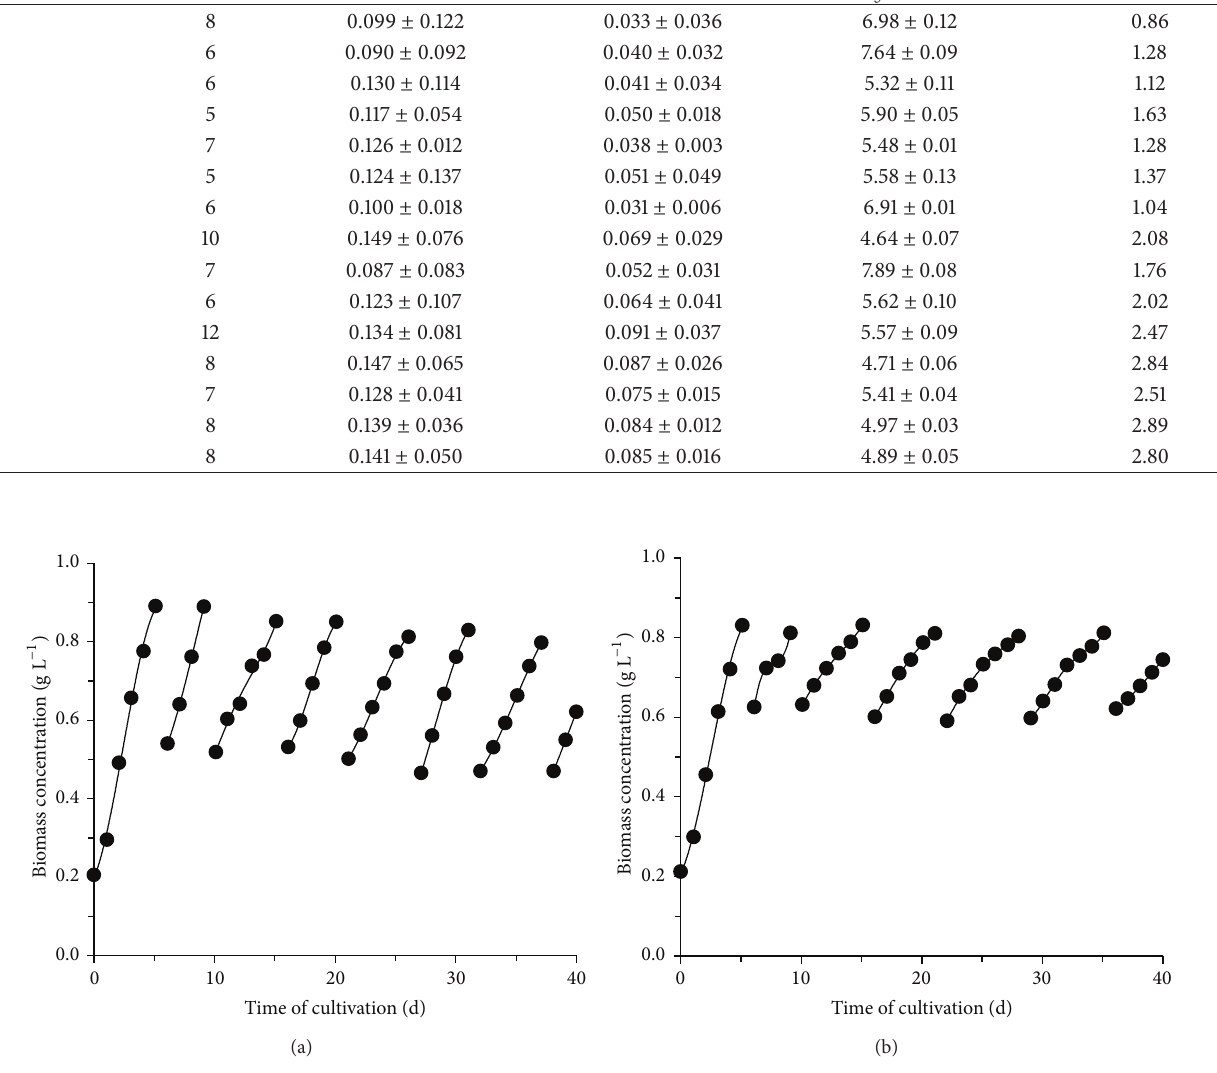
concentration of 0.40 g L −1 , regardless of the medium